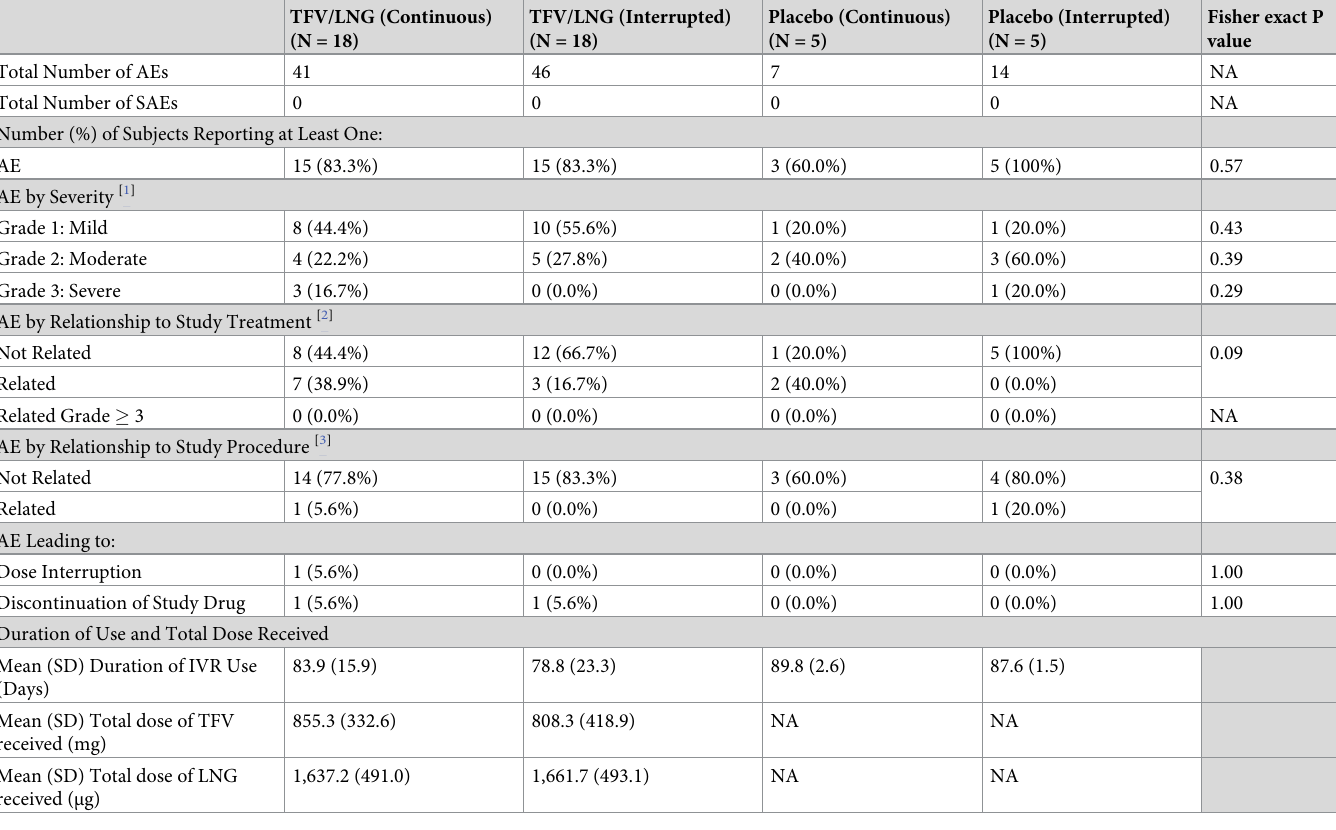
Table 2. Summary of duration of use, total dose received and adverse